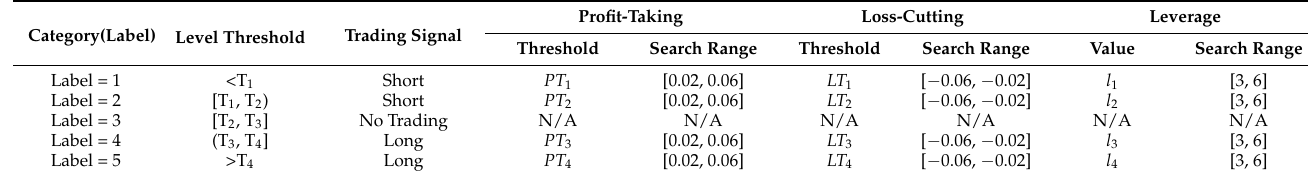
Table 2. The parameters of the trading rule. Note that N/A means no parameters need to be optimized since no simulation trading is executed.